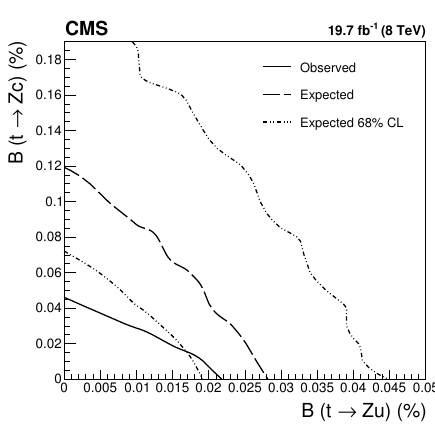
Figure 8 . The expected and observed exclusion limits at 95% CL on B (t ! Zc) as a function of the limits on B (t ! Zu). The expected 68% CL is also shown.